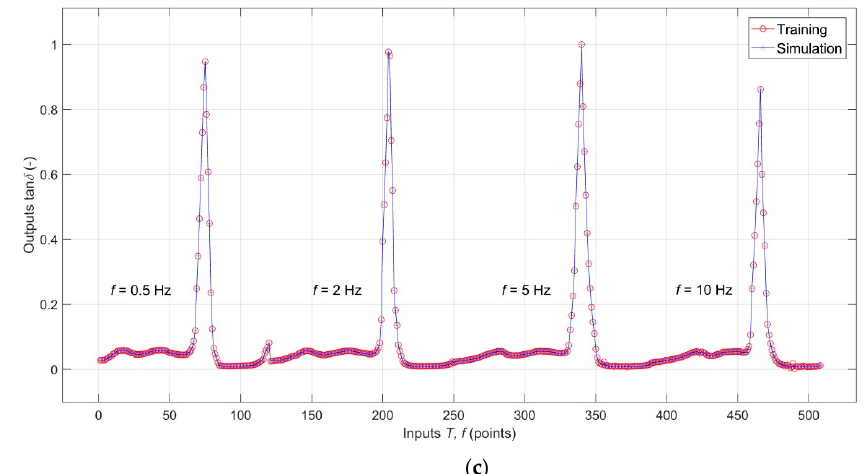
Figure 5. ( a ) Comparison of the training target with simulated training outputs for E ′ ( T, f ); ( b ) Comparison of the training target with simulated training outputs for E’’ ( T , f ); ( c ) Comparison of the training target with simulated training outputs for tan δ ( T , f ).